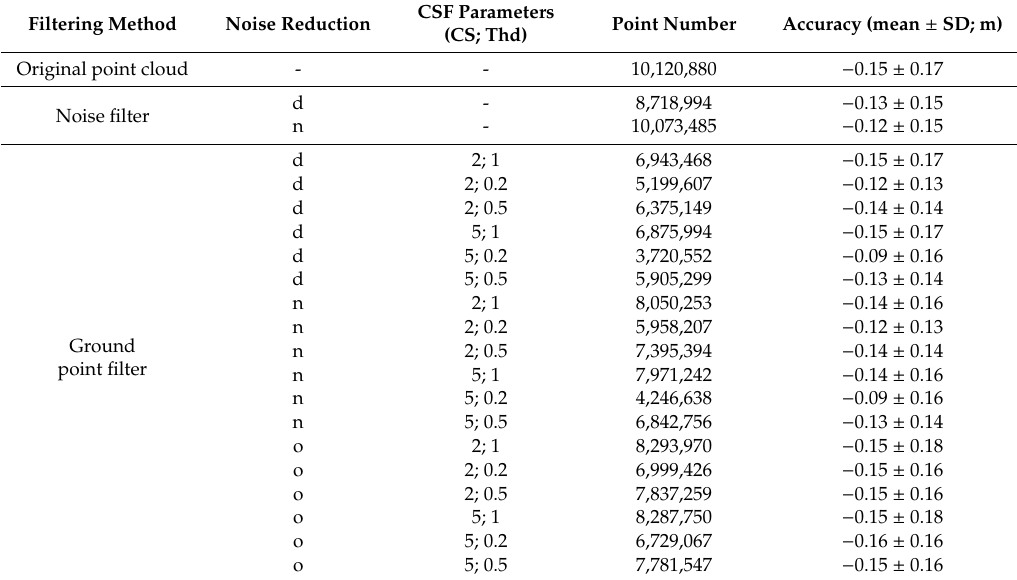
Table 2. Accuracies as reflected in the noise reduction and CSF parameters (o: original LAS dataset; d: distance-based filter with island detection; n: neighborhood-based filter; CS: cloth size; Thd: threshold; SD: standard